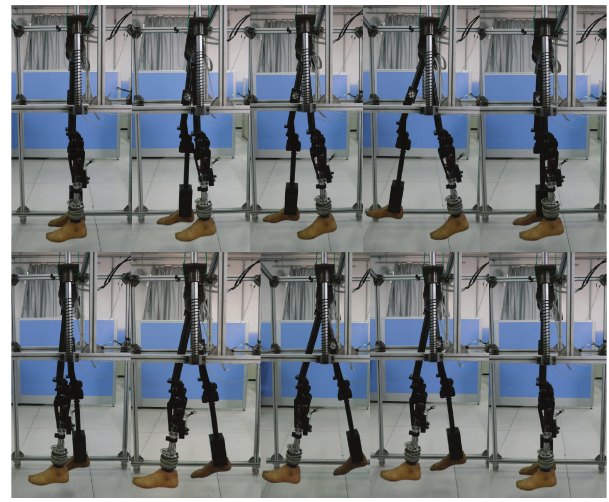
Figure 12: Step sequence in swing phase.